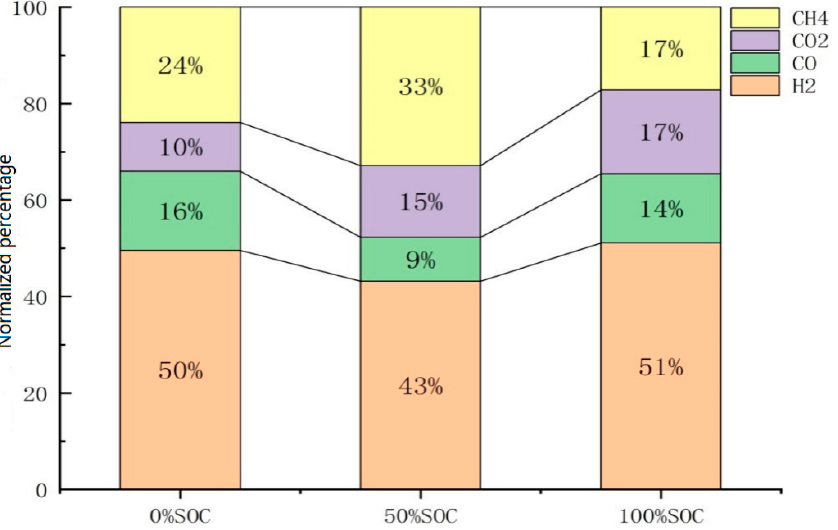
Figure 8. Normalized percentage of lithium iron gas production constituents. From the perspective of gas production, H 2 accounts for a relatively high proportion of the gas generated by lithium iron phosphate ba tt eries, approaching about 50%.